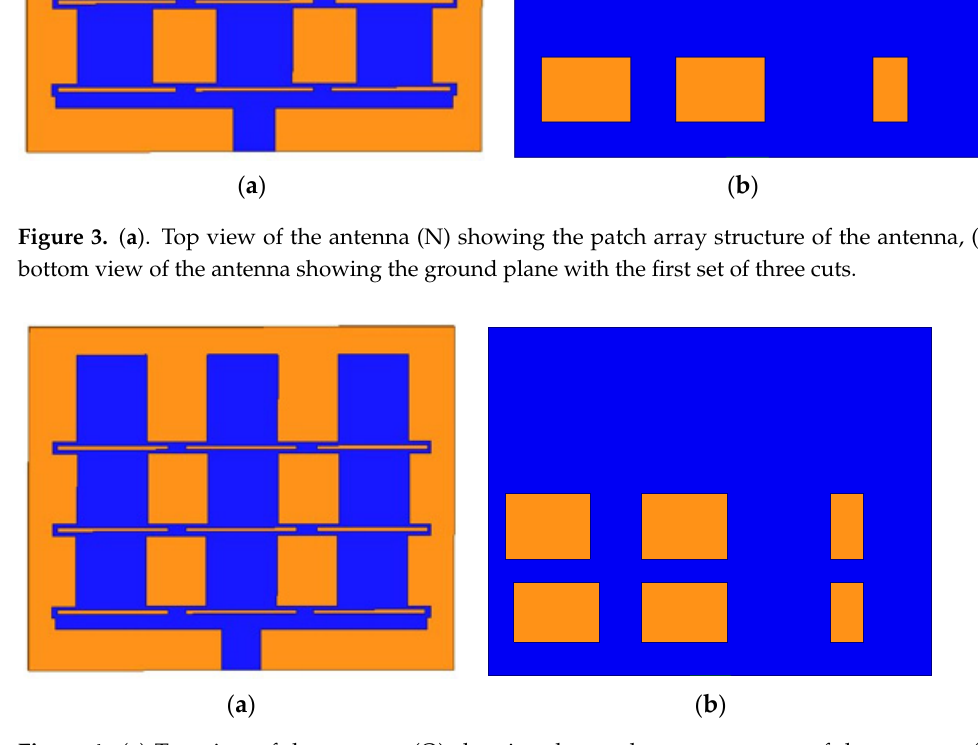
Figure 4. ( a ) Top view of the antenna (O) showing the patch array structure of the antenna, ( b ) bottom view of the antenna showing the ground plane with the second set of three cuts.